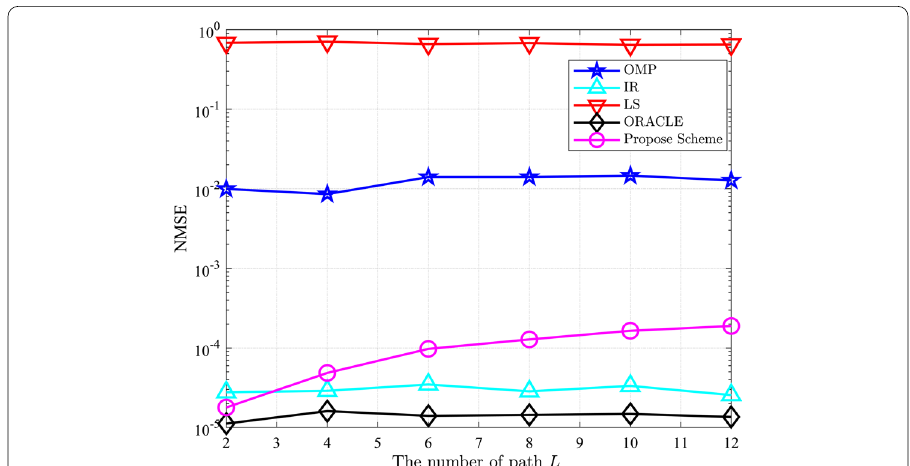
Fig. 9 NMSE performance against L when N x = N y = 32 , N t = N r = 64 , N RF r = N RF t = 2 are considered, respectively